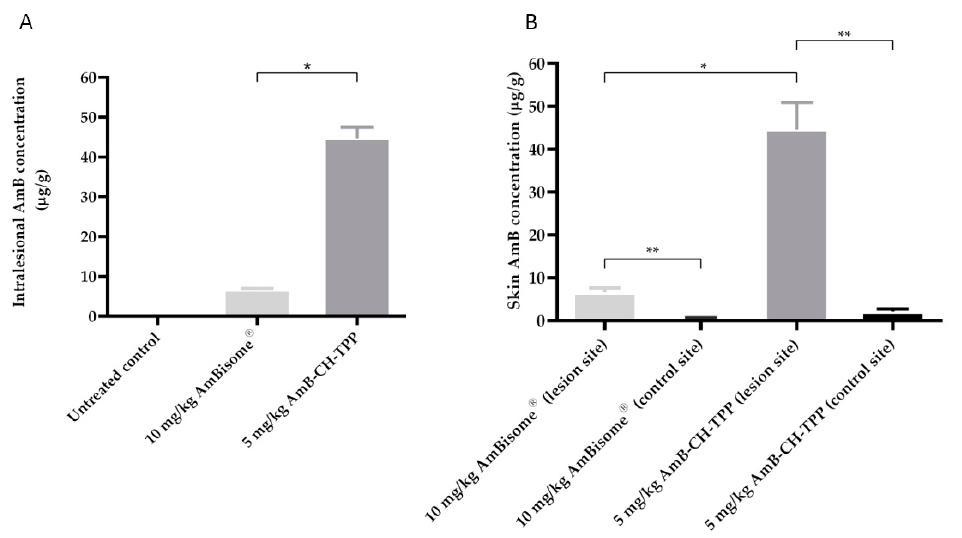
Figure 3. Multiple dose skin pharmacokinetics of AmB-CH-TPP nanoparticles and AmBisome.